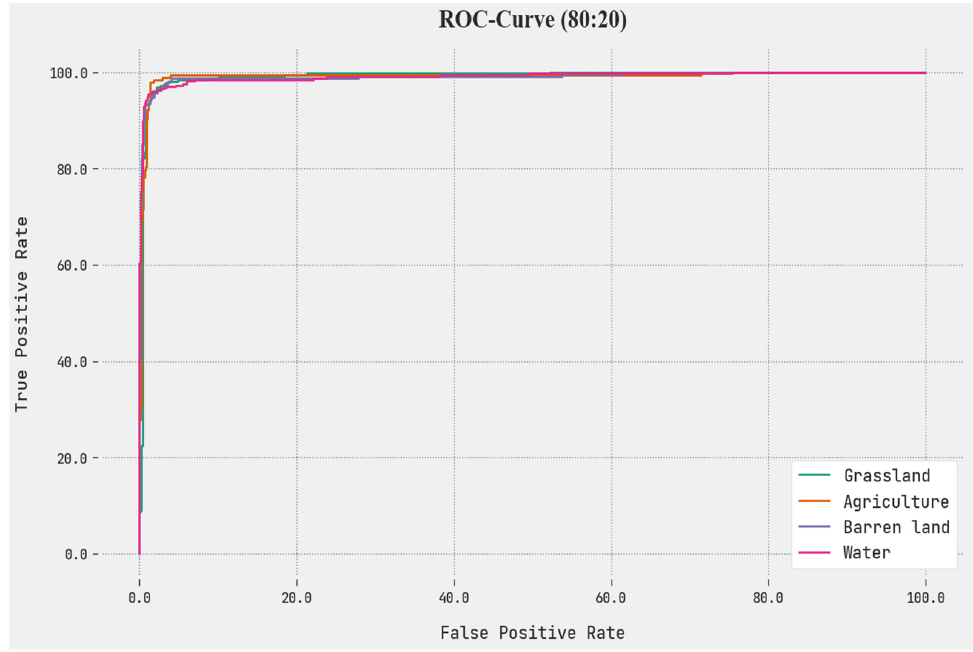
Figure 9. ROC analysis of TSADL-LULCCD approach on 80:20 of TR/TS databases.